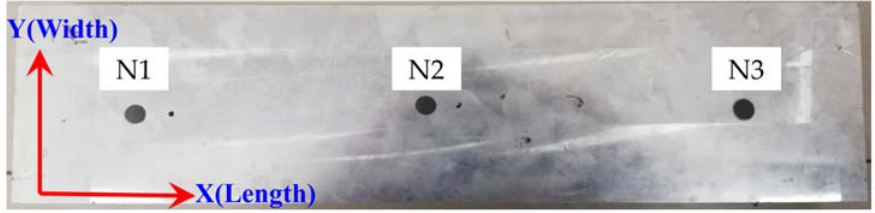
Figure 2. The sample surface indicating the coordinate system.